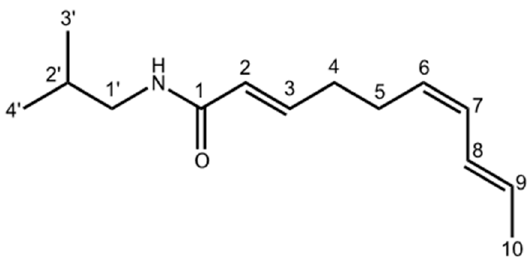
Figure 2. Chemical structure of affinin, the major alkamide in H. longipes roots.